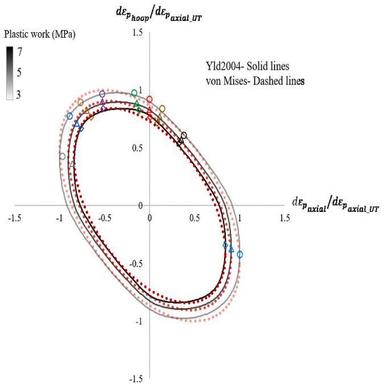
AA7075-O extruded tube's normalized conjugate plastic strain-rate potential evolution for different plastic work levels.